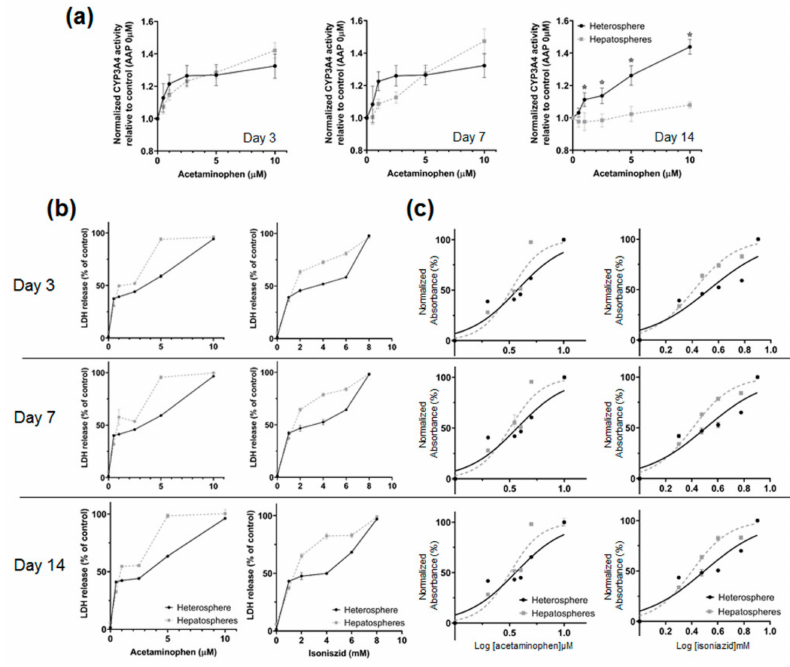
Figure 6. ( a ) Luminescence assay of cytochrome P450 activity in the hepatospheres and heterospheres after AAP treatment. Cytochrome P450 enzyme activity was detected according to the luminescence emitted upon addition of a detection reagent; the degree of luminescence emitted was measured using a luminometer. ( b ) The assessment of cell death using the LDH assay. The hepatospheres and heterospheres were treated with AAP and INH for 24 h. Data are depicted as the percentage of the total LDH amount. All values are showed as the mean ± SE of four independent experiments. * p < 0.05 ( c ) IC 50 Determination curve. Table 1. IC 50 values for AAP and INH in the hepatosphere and heterospheres. IC 50